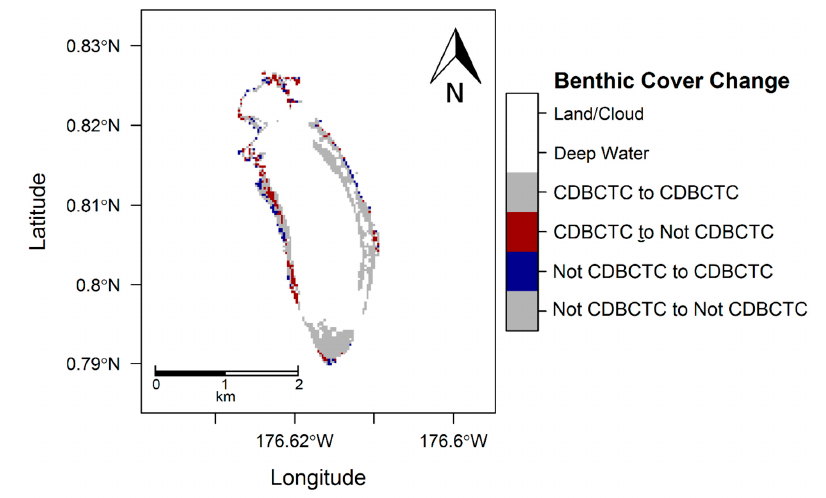
Figure 12. Difference in predicted class membership map for the Howland Island area of interest for 2001 initial state compared to 2015 final state.